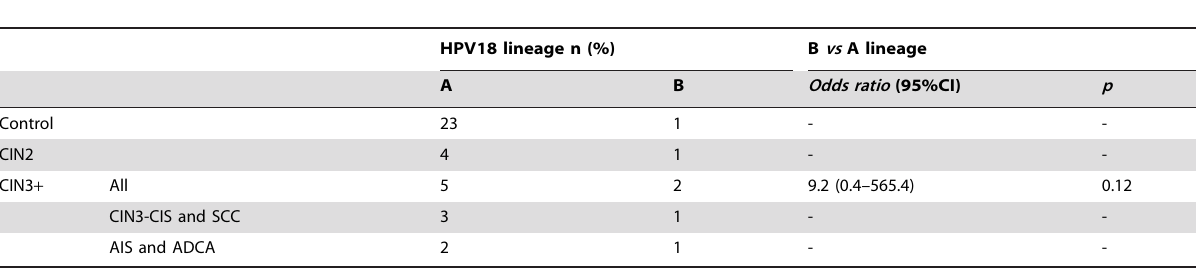
CIN2: Cervical intraepithelial neoplasia grade 2. CIN3-CIS: CIN grade 3-carcinoma in situ. SCC: Invasive squamous cell carcinoma. AIS: Adenocarcinoma in situ . ADCA: Adenocarcinoma. CIN3 + includes CIN3-CIS, SCC, AIS, and ADCA. p , control group as reference.